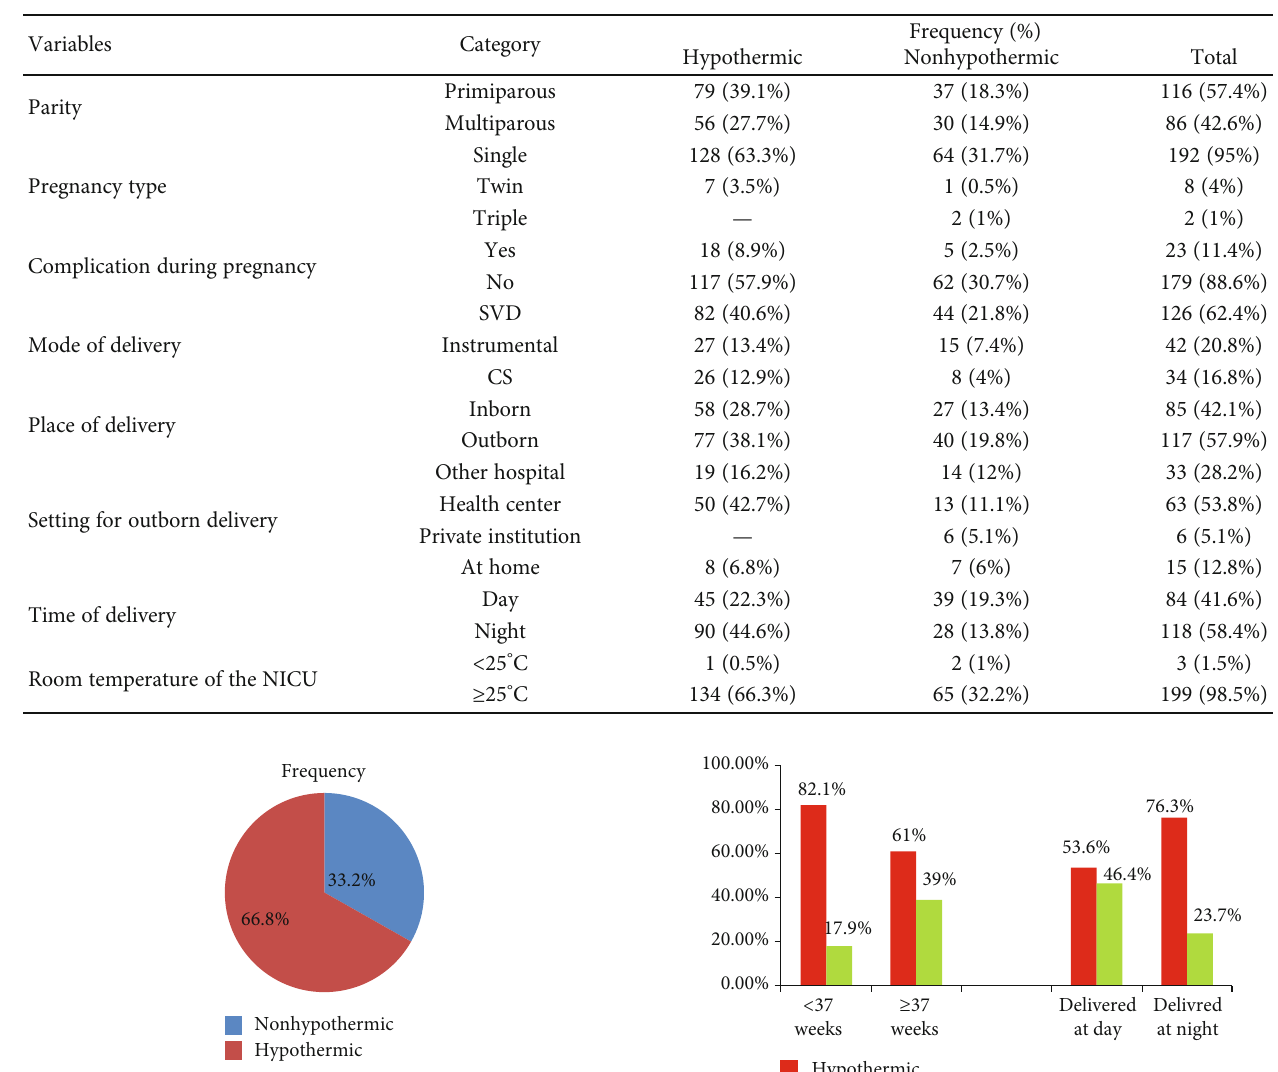
Figure 1: Distribution of neonates in relation to the presence of hypothermia in Dessie Referral Hospital, Northeast Ethiopia, 2018 ( N = 202 ).